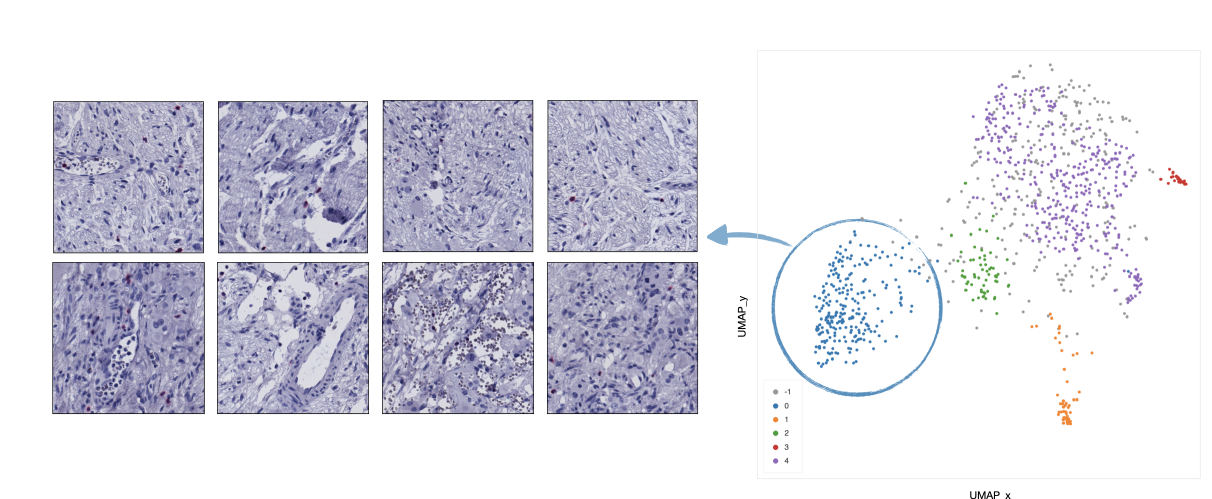
Figure 9. Example of 8 representative tiles with stroma rich areas with low level of TILs, grouped as cluster 0 by UMAP and HDBSCAN.